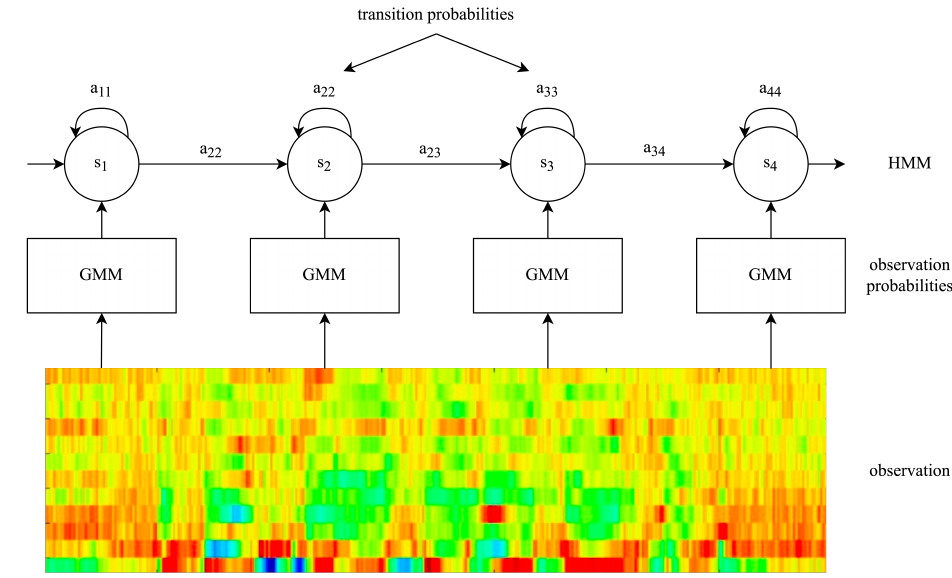
Figure 1. Hidden Markov Model-based model for Automatic Speech Recognition.